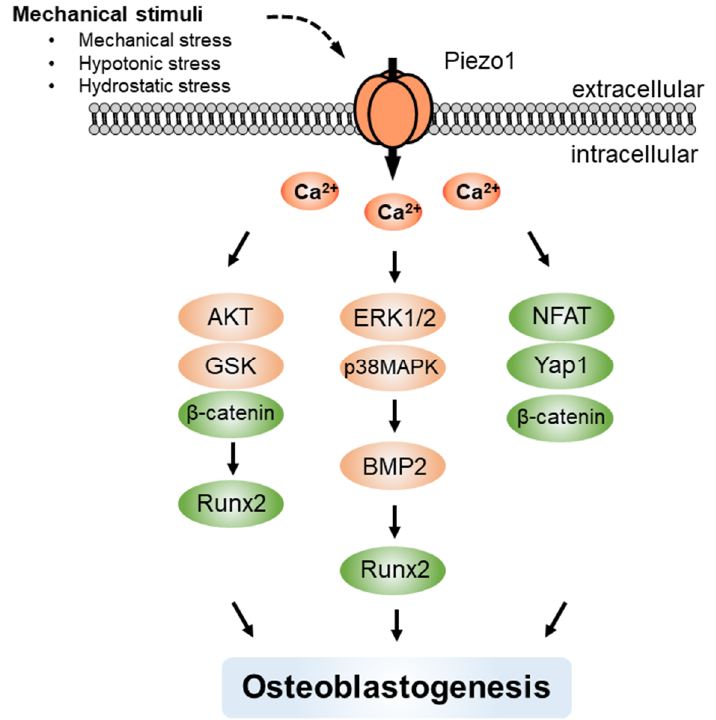
Figure 4. Mechanical stress stimulates Piezo1 to promote Ca 2+ influx in osteoblast lineage cells. The [Ca 2+ ] i rises regulate various signal transduction pathways, resulting in osteoblastogenesis. Osteoblast lineage-specific, Piezo1-deficient mice ( Piezo1 OcnCre ) showed severely im- Piezo1-conditional-deficient mice, Piezo1 Prrx1Cre , exhibited multiple skeletal fractures